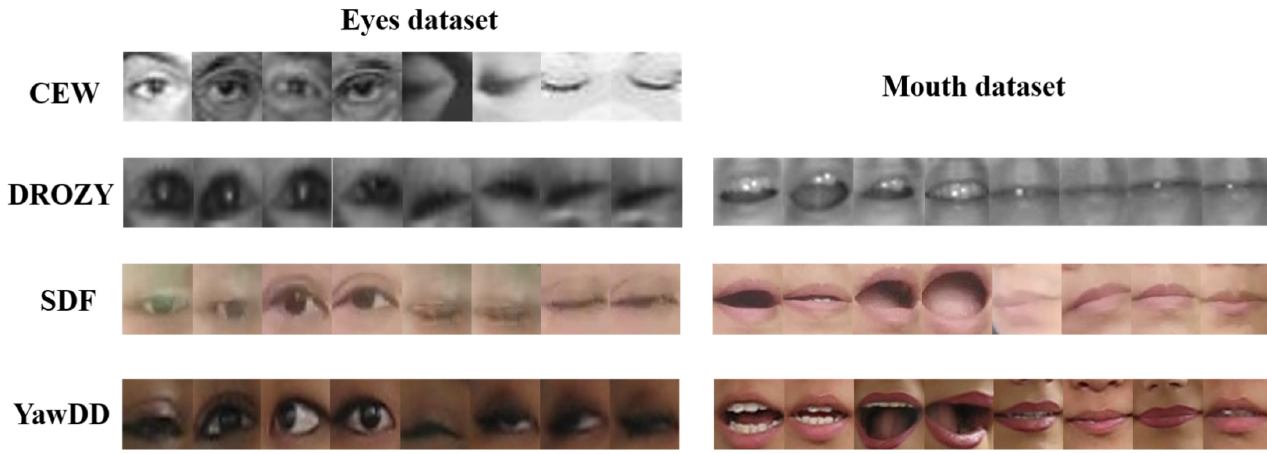
Figure 5. All datasets used in this study.